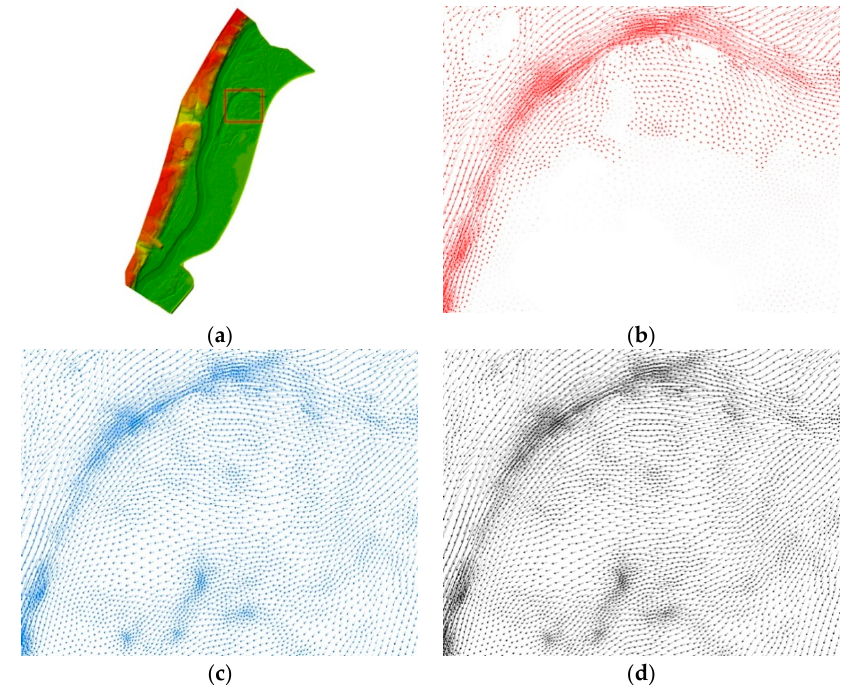
Figure 11. Comparison of the velocity distributions obtained from the 2D model for the flow rate equal to 279.1 m 3 ·s − 1 : ( a ) DEM with the comparison area marked as the red rectangle; ( b ) original DEM; ( c ) corrected DEM; and ( d ) reference DEM.